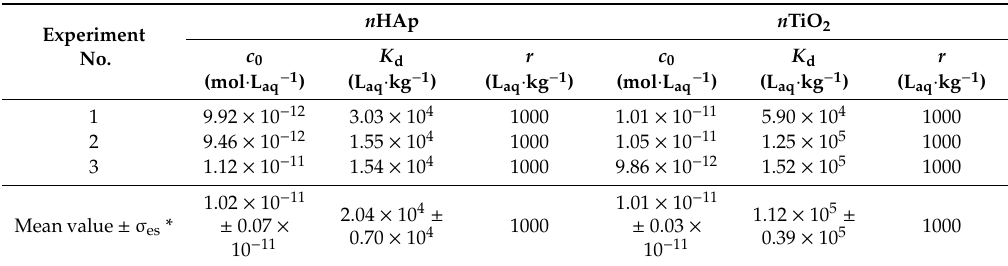
Table 3. Starting aqueous phase concentrations of 223 Ra, c 0 , and the values of parameters K d and r in kinetic experiments of sorption on n HAp and n TiO 2 (at t = 0). Experiment